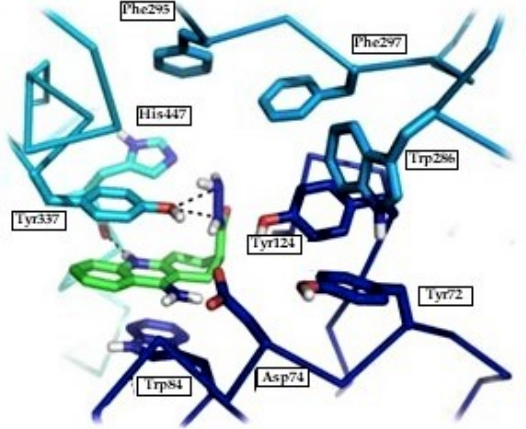
Figure 7. Molecular modeling of 36c with Tc AChE showing the interaction with the CAS (adapted from [94], with permission from Elsevier). Key interactions noted are the tacrine moiety π-π stacking with Trp84 and Tyr337 and H-bonding to His447 and the hydrazide H-bonding with Tyr337.